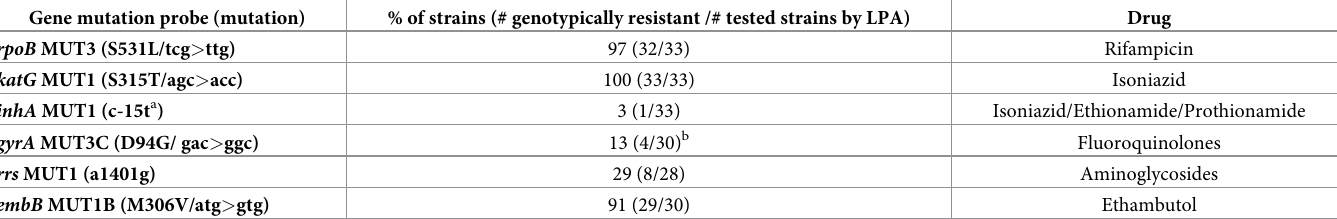
Table 3. Frequency of mutations associated with drug resistance in “modern” Beijing strains from Southwestern Colombia. Gene mutation probe